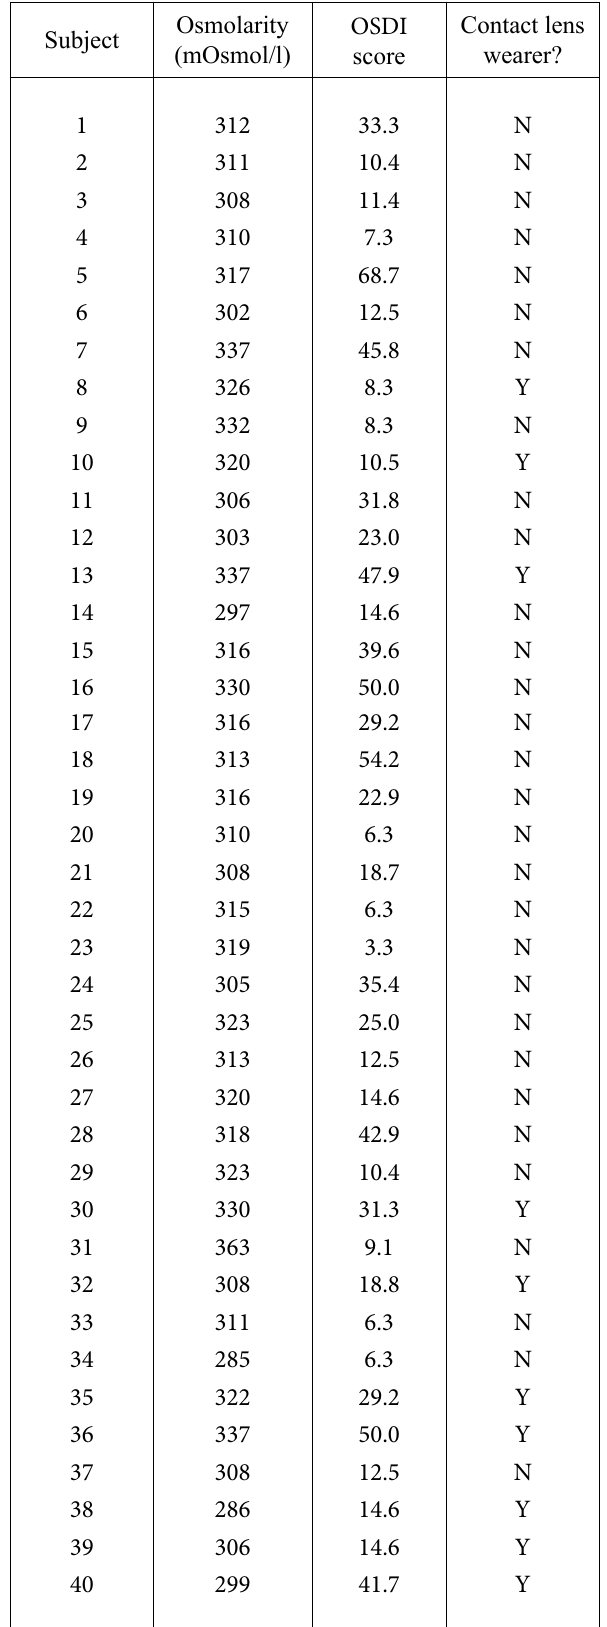
Table 1 . Data collected from 40 subjects. Mean osmolarity